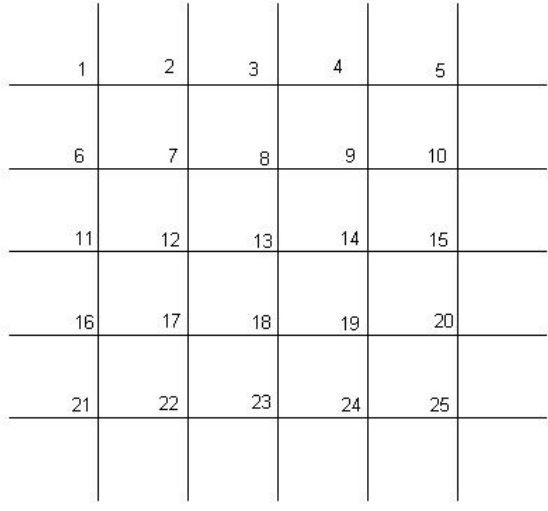
Figure 4. Planning area transportation network.